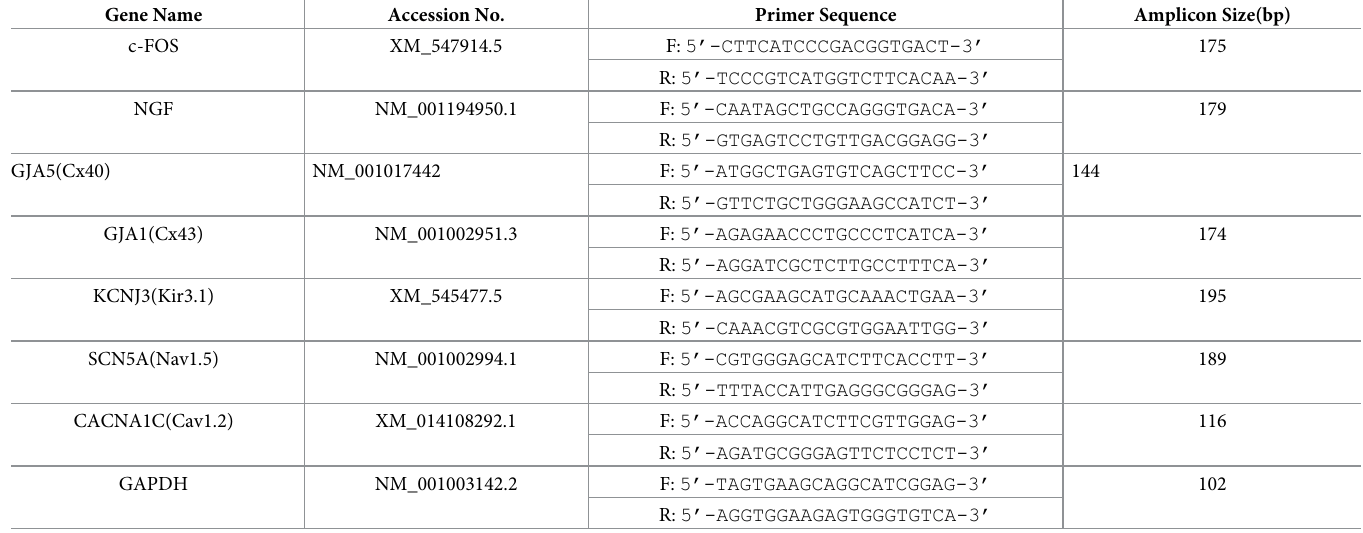
Table 1. Primer sequences for